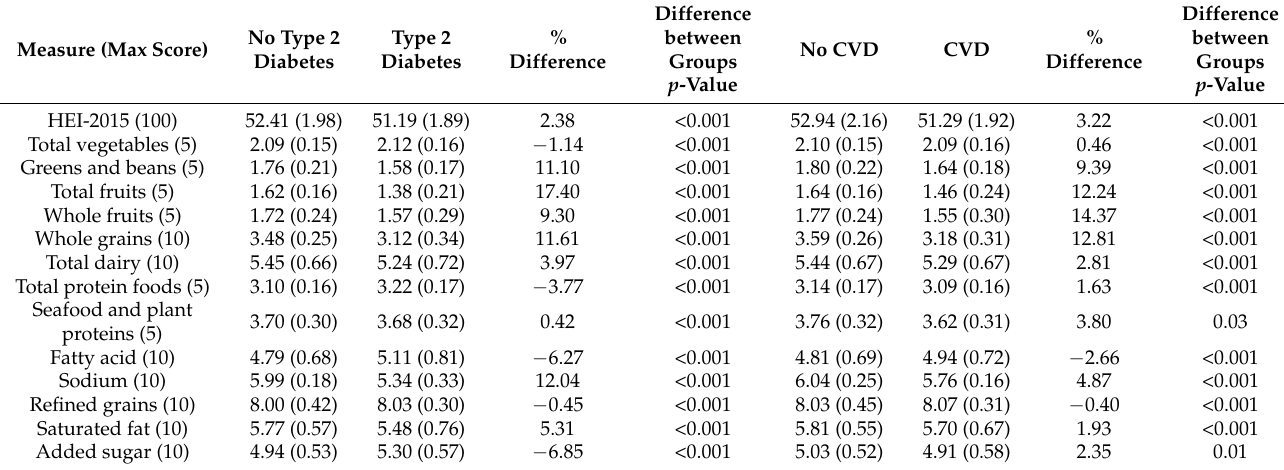
Table 4. Adjusted weighted mean HEI-2015 and component scores (standard deviations) for households with and without a member with reported T2D or CVD, based on Consumer Network (CN) 2015-MedpProfiler data.